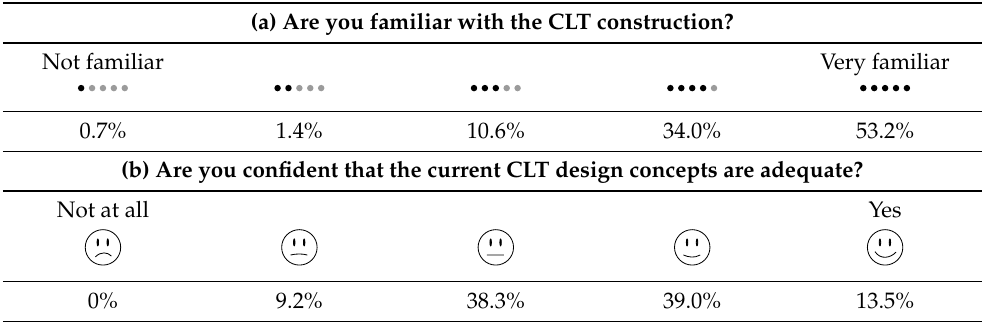
Table 3. Participants knowledge on cross laminated timber, CLT (single